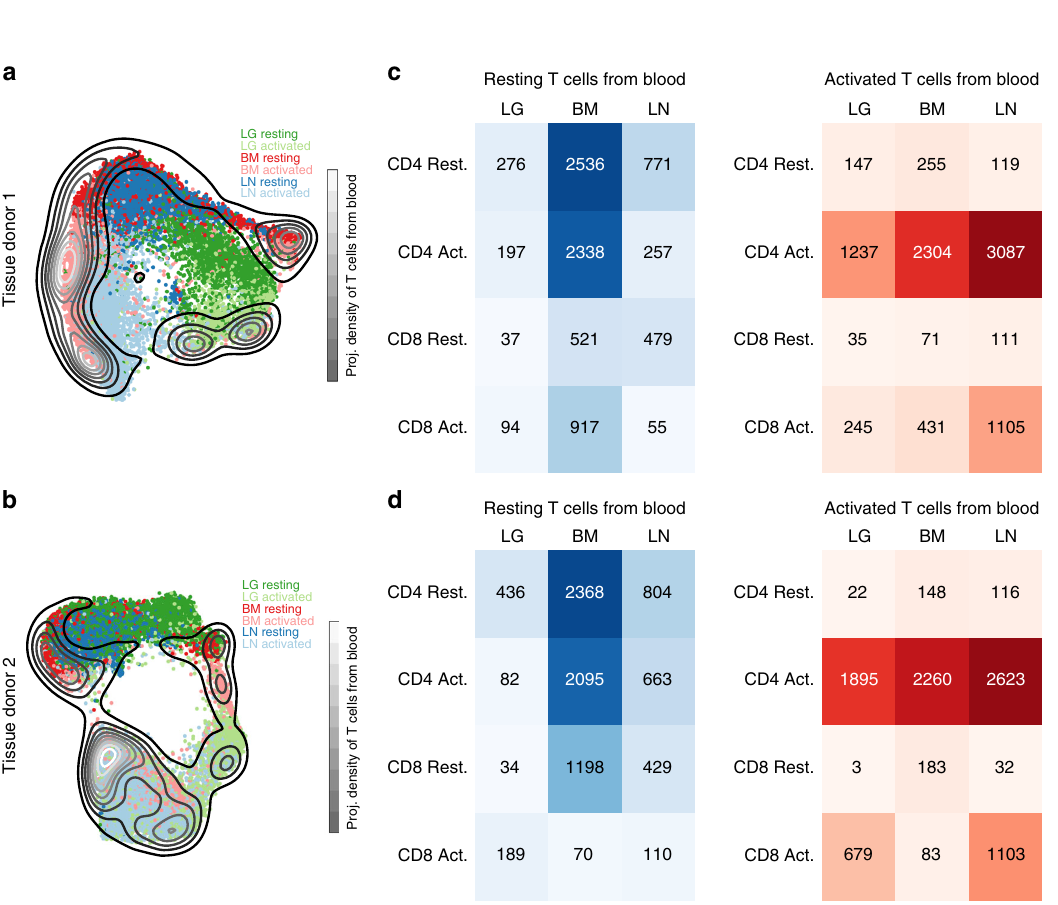
Fig. 1 Single-cell RNA-seq analysis of resting and activated T cells from multiple tissue sites. a Experimental work fl ow for single-cell analysis of T cells from human tissues and blood including magnetic negative selection of CD3 + cells, in vitro culture and activation, and Chromium 3 ′ -scRNA-seq. b UMAP embeddings of merged scRNA-seq pro fi les from resting and activated T cells from lung (LG), bone marrow (BM), and lung-draining lymph node (LN) in each of two organ donors colored by resting/activated condition, CD4/CD8 expression ratio (all cells in a given cluster assigned the same average value), and tissue source. c Identi fi cation of T cell subpopulations. UMAP embeddings colored by expression cluster along with heatmaps showing z-scored average expression of curated T cell subset marker genes that had a fold change >2 and p < 0.05 by the binomial test for at least one cluster. Genes are ordered by the cluster in which they have the highest enrichment. Subsets designated based on resting ( “ rest ” ) or activated ( “ act ” ) condition and expression of known markers denoting effector memory (TEM), tissue resident memory (TRM), terminally differentiated effector cells (TEMRA), and